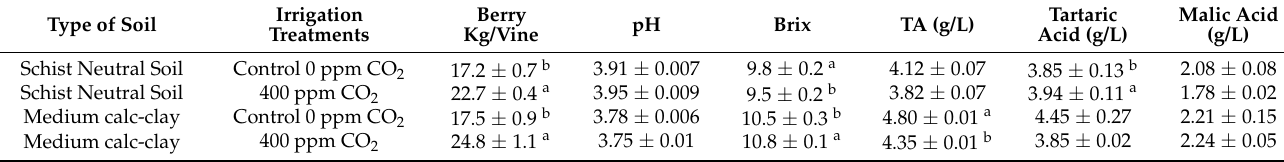
Table 10. Quantitation of yield components and grape composition. V. vinifera (L.) cv. Tempranillo plants in pots with two different substrates. Treatments: schist soil and medium calcareous clay soil (medium calc-clay), treated with non-acidified water (control pH 7.5) and 400 ppm CO 2 -acidified water (pH 6.5). Brix = total soluble solids, TA = titratable acidity. The results correspond to three- year-old plants. a,b : different letters denote a statistically significant difference ( p < 0.05) between treatment for the same type of soil. Values with different letters denote a statistically significant difference ( p < 0.05). The results show the mean value and standard